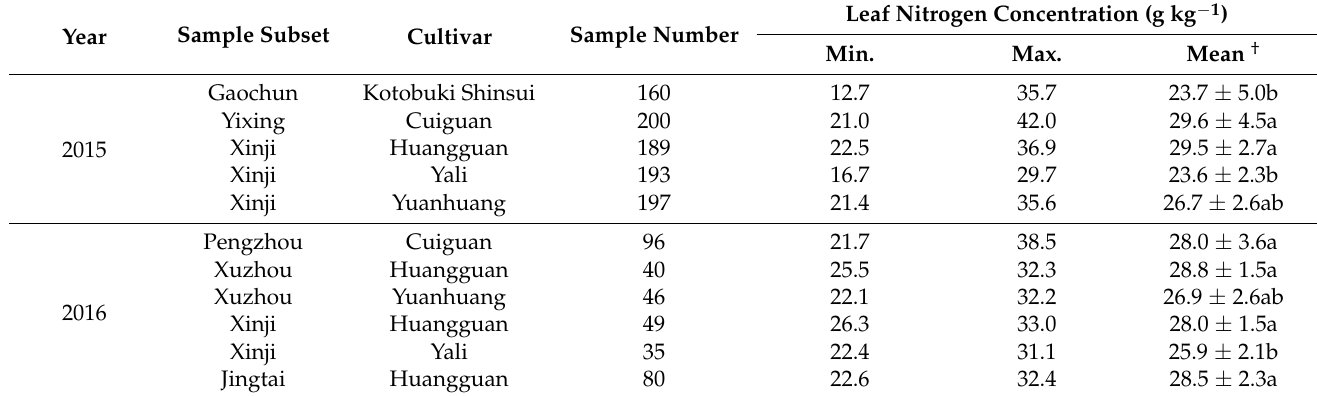
Table 2. Statistics of leaf nitrogen concentrations of different